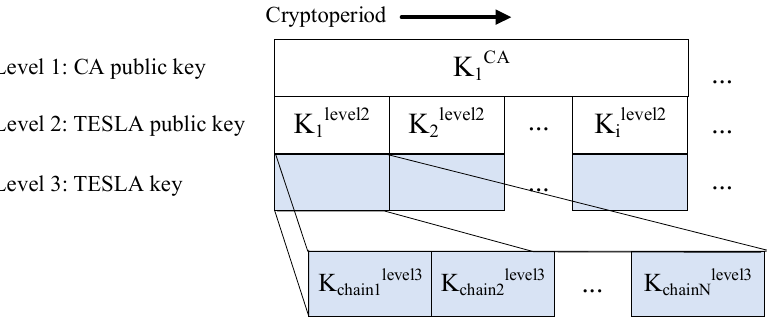
Figure 11. Three-level scheme based on the TESLA protocol [72]. Table 8. Key management scheme.